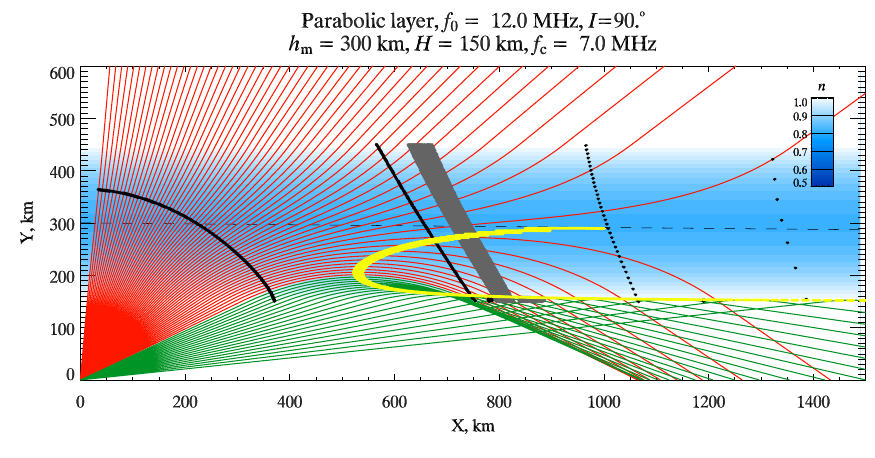
Fig. 1. Ray trajectories for a simplified model (see text for details). The blue shading represents a spatial distribution of the refractive index ( 2). The red and green lines show high-angle rays (escaping and Pedersen) and low-angle rays, respectively. The yellow contour shows an area where k ⊥ B 0 is satisfied to within 1 ◦ . Black contours/dots show group range marks at 400-km intervals. The grey area corresponds to the effective scattering volume for range gate #15 (group range resolution